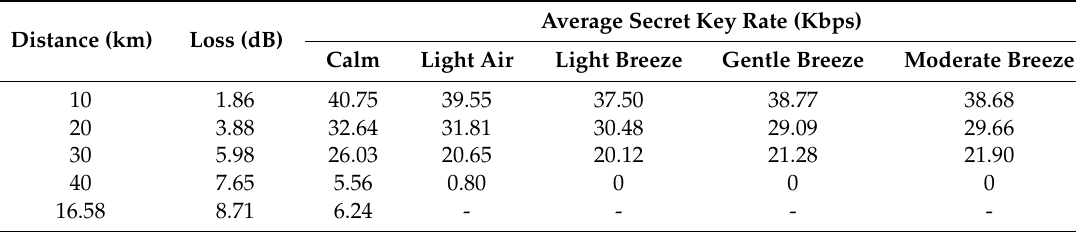
Table 4. Quantum key rates of distance loss test and gallop loss test.